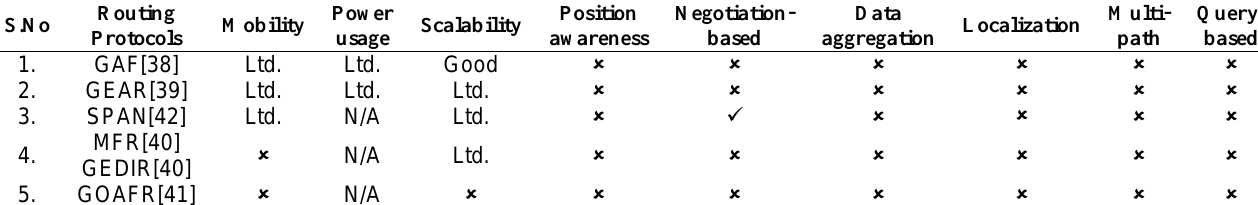
Table 4. Classification of location based routing